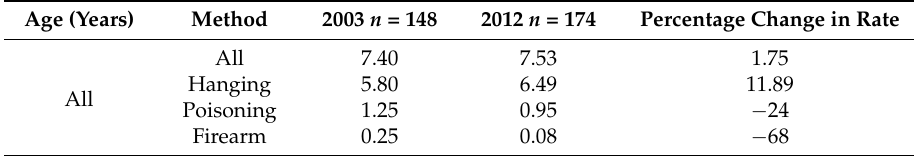
Table 1. Suicide rate per 100,000 persons by age group and suicide method in the state of Tabasco from 2003 to